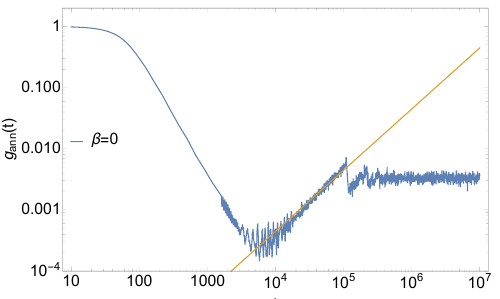
Figure 8. Annealed SFF of BTZ normal modes with J cut = 300 , β = 0 and n = 1 . Averaging is done over hundred randomly chosen z from a normal distribution with mean µ = 20 and variance 0 σ = 0 . 1 . The equation of yellow straight line is log g ann ( t ) = log t +